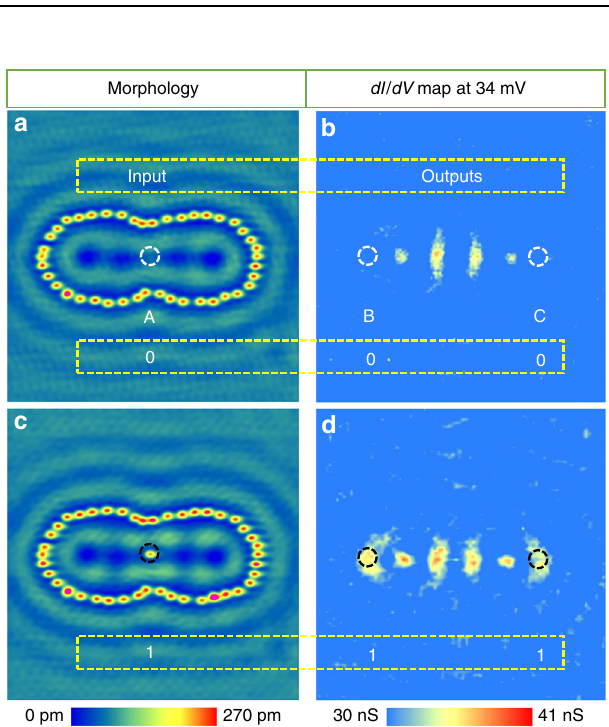
Fig. 6 Pseudo FANOUT gate. a Topography of a confocal EQC (both the EQCs used to build the confocal EQC have the same size of a = 6.6 nm and e = 0.7). The joint focus A is used as the input and the other two foci B and C are the outputs. b The corresponding dI/dV map of panel a at the bias voltage of + 34 mV. c Topography of the same confocal EQC in panel a but with an additional Fe adatom placed at A. d The corresponding dI/dV map of c at the same bias voltage of + 34 mV. Dashed circles mark the focal positions, for which black means 1 and white means